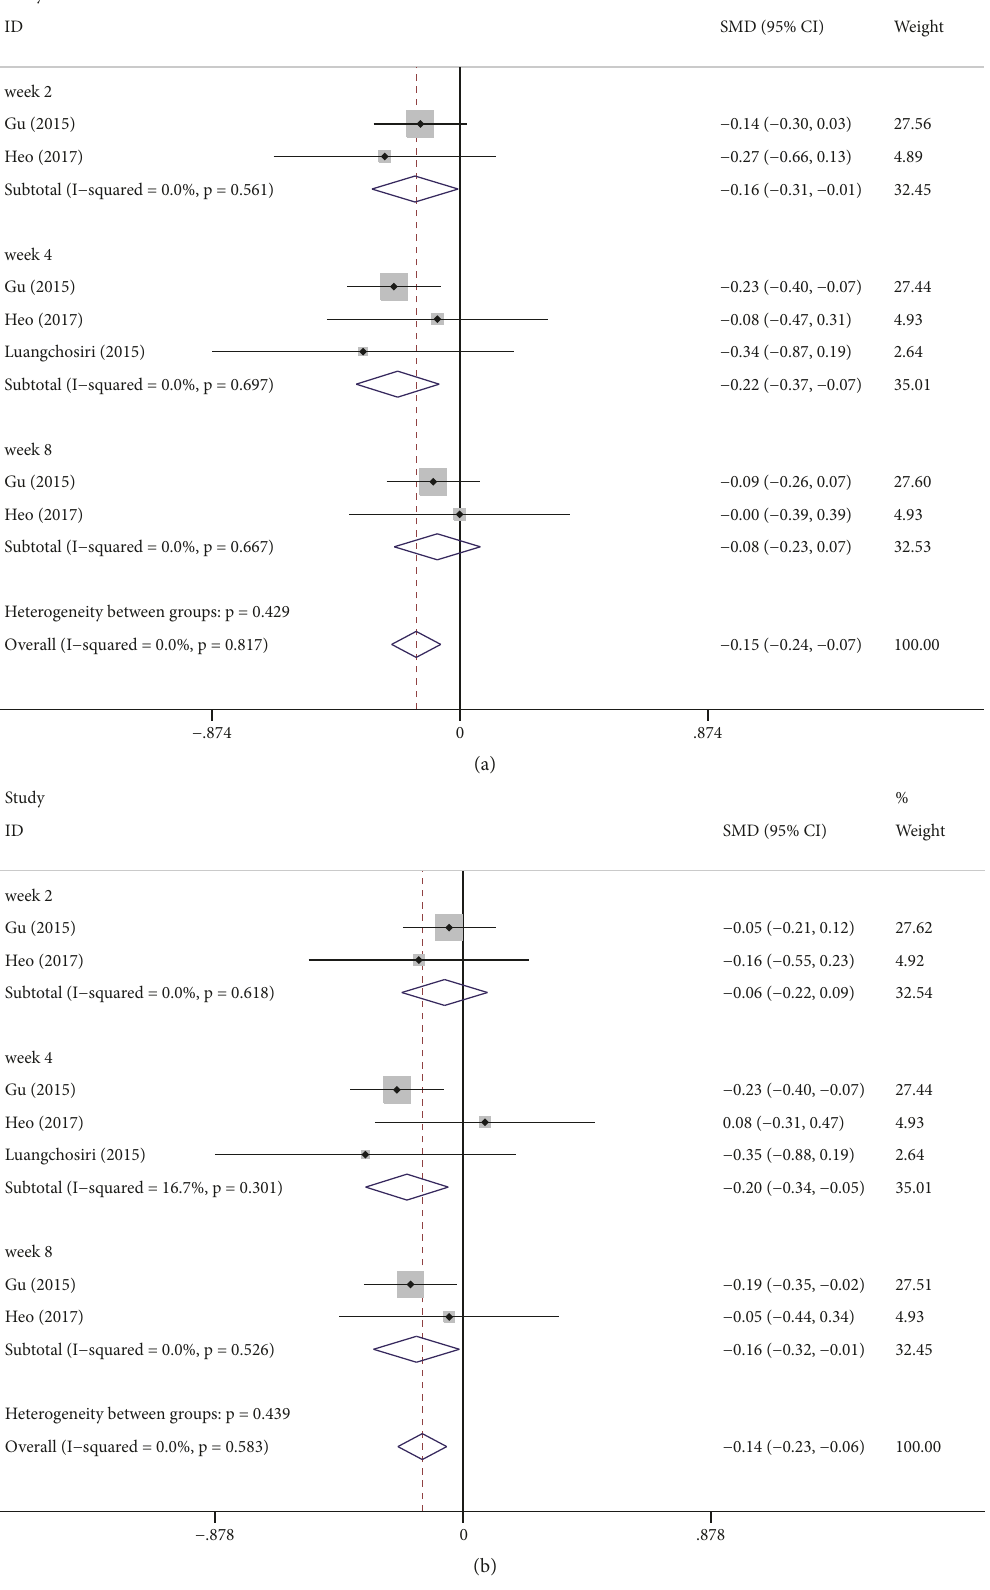
Figure 3: Effect of silymarin on changes in the liver function tests. (a) Alanine aminotransferase (ALT). (b) Aspartate aminotransferase